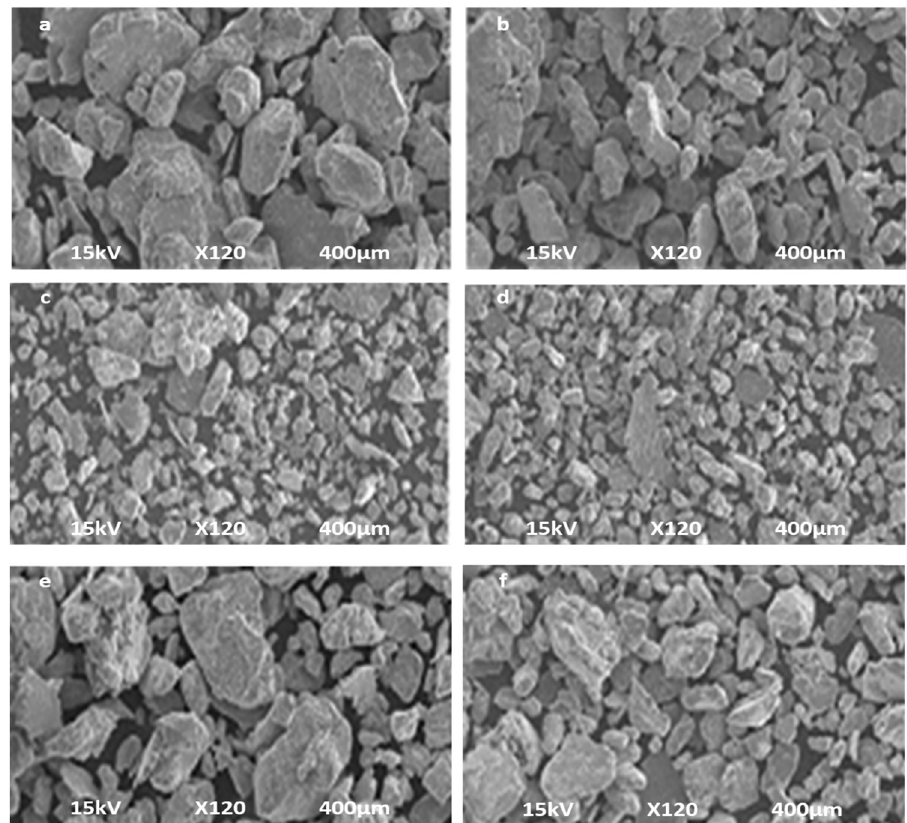
Figure 11: SEM micrographs of Al – Cu – Mg – T351/MWCNT nanocomposite pulverized powder mechanical alloyed for speci fi c time period according to the percentage weight content of